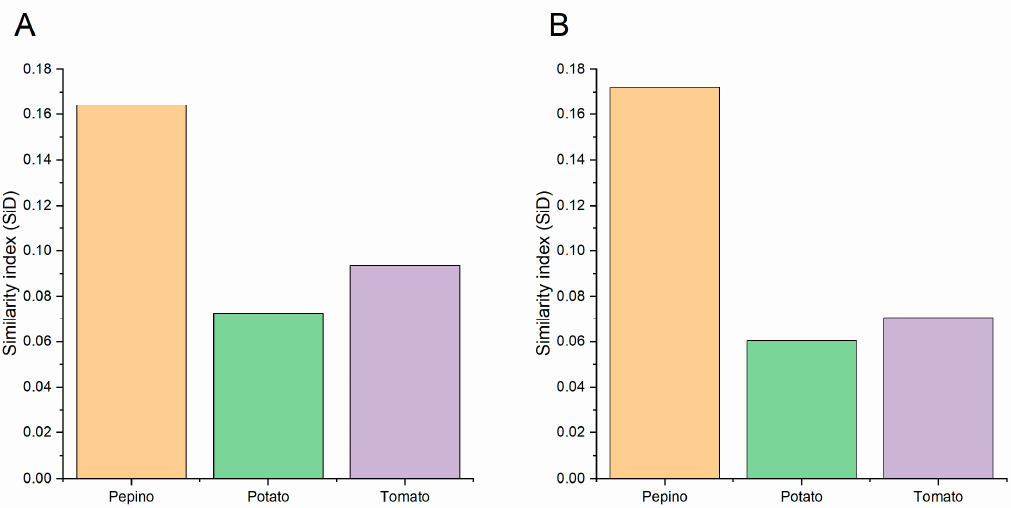
Figure 8. The similarity index (SiD) analysis of the PVM CP ( A ) and NABP ( B ) genes in relation to the natural hosts synonymous codon usages. The pepino, potato and tomato hosts are represented in light orange, light green and light purple, respectively. The x axis represents the sequences identified in different hosts.